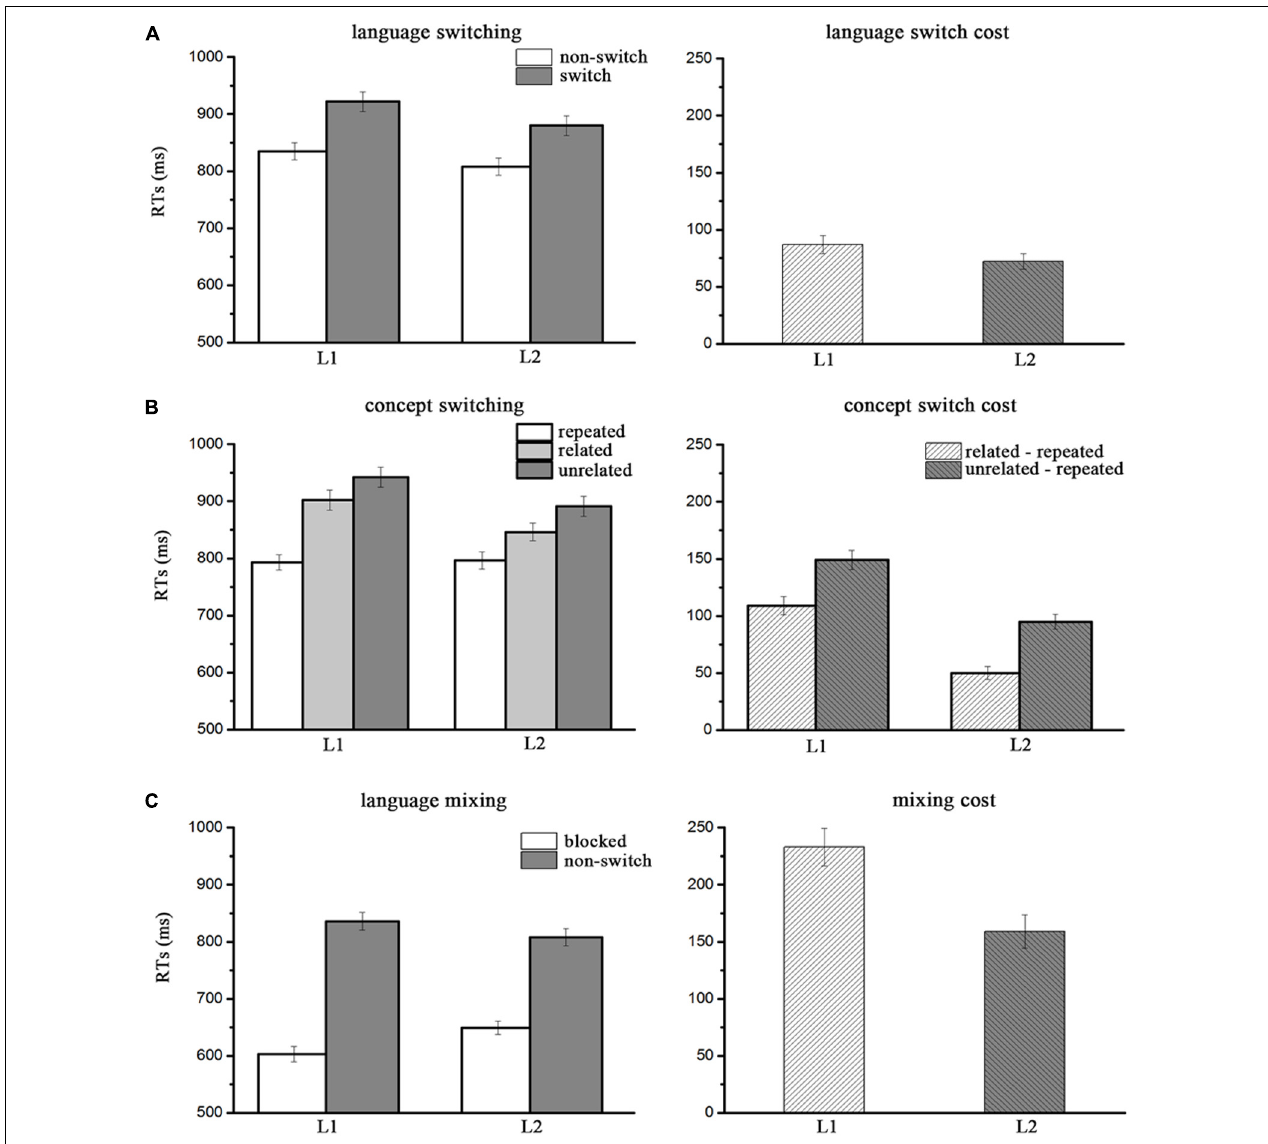
FIGURE 3 | (A) Naming response times (in milliseconds; left) and switch costs (right) collapsed by language switch (switch and non-switch) for L1 and L2. (B) Naming response times (left) and switch costs (right) as collapsed by concept switching (repeat, related, and unrelated) for L1 and L2. (C) Naming response times (left) and mixing costs (right) as collapsed by language context (blocked and non-switch) for L1 and L2. Error bars represent standard